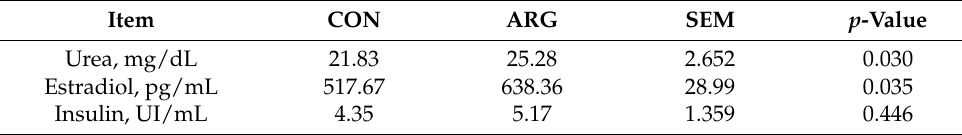
Table 4. Blood parameters of sows ( n = 23) at 110 days of gestation fed CON or ARG diet. Item